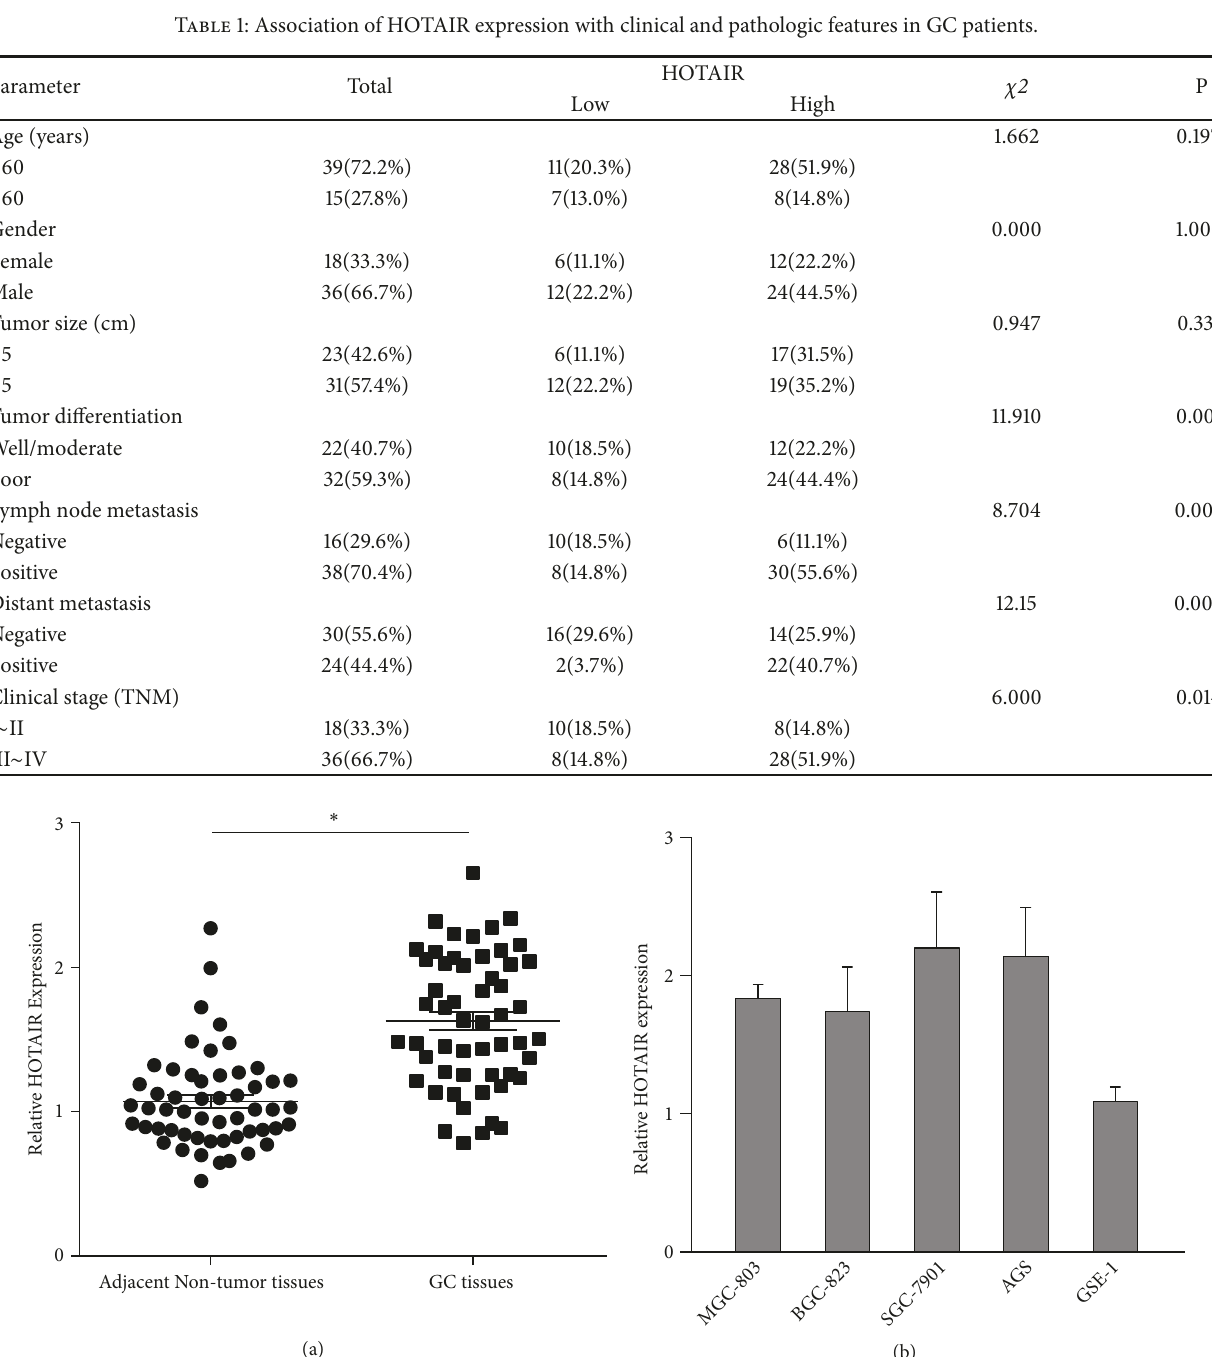
Figure 1: The expression levels of HOTAIR were significantly upregulated in GC tissues and cells. (a) Difference between the expression levels of HOTAIR in 54 pairs of GC tissues and adjacent nontumor tissues. (b) The expression levels of HOTAIR in human GC cell lines AGS, MGC-803, SGC-7901, BGC-823, and a normal gastric epithelium cell line GES-1. The expression levels of HOTAIR were normalized to GAPDH. ∗ P <